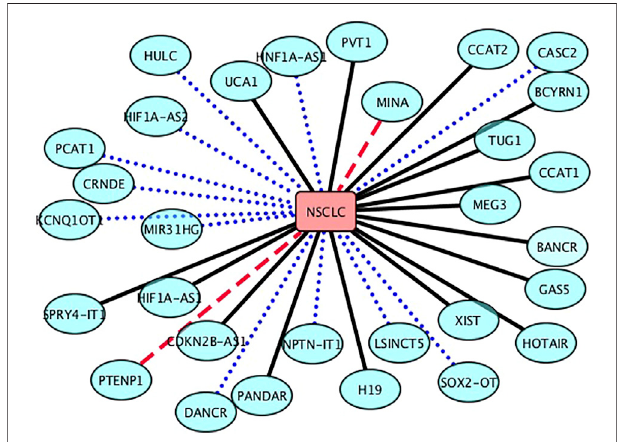
FIGURE 3 | Associations between the inferred top 30 lncRNAs and NSCLC. Black solid lines represent known LDAs in the lncRNADisease database. Blue-dot lines represent LDAs that can be observed in the MNDR database. Red-dash lines represent LDAs predicted to be potential lncRNA biomarkers of LN.